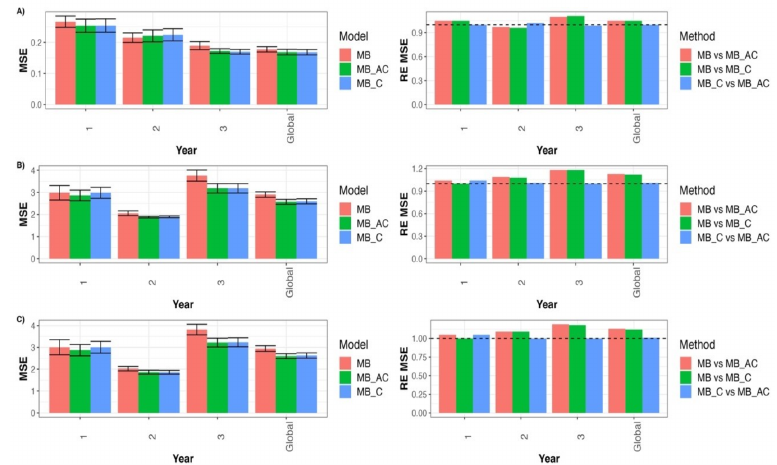
Figure 2. Prediction performance in terms of mean square error (MSE) for models MB, MB_C, and MB_AC for each trait in each environment and across environments (Global) under untested lines in a tested environment cross-validation strategy. The relative efficiencies (RE_MSE) were computed to compare models MB_C vs. MB_AC, MB vs. MB_C, and MB vs. MB_AC. ( A ) for GY trait, ( B ) for DTF trait, and ( C ) for DTH trait.